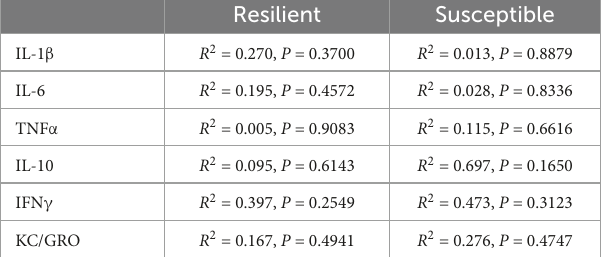
TABLE 1 Correlations between PFC and serum in RISP classified res and Sus animals. Resilient